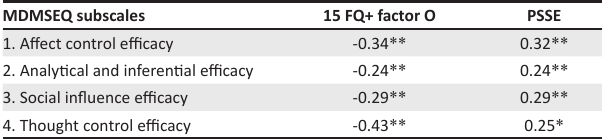
TABLE 4: Correlation of MDMSEQ with similar